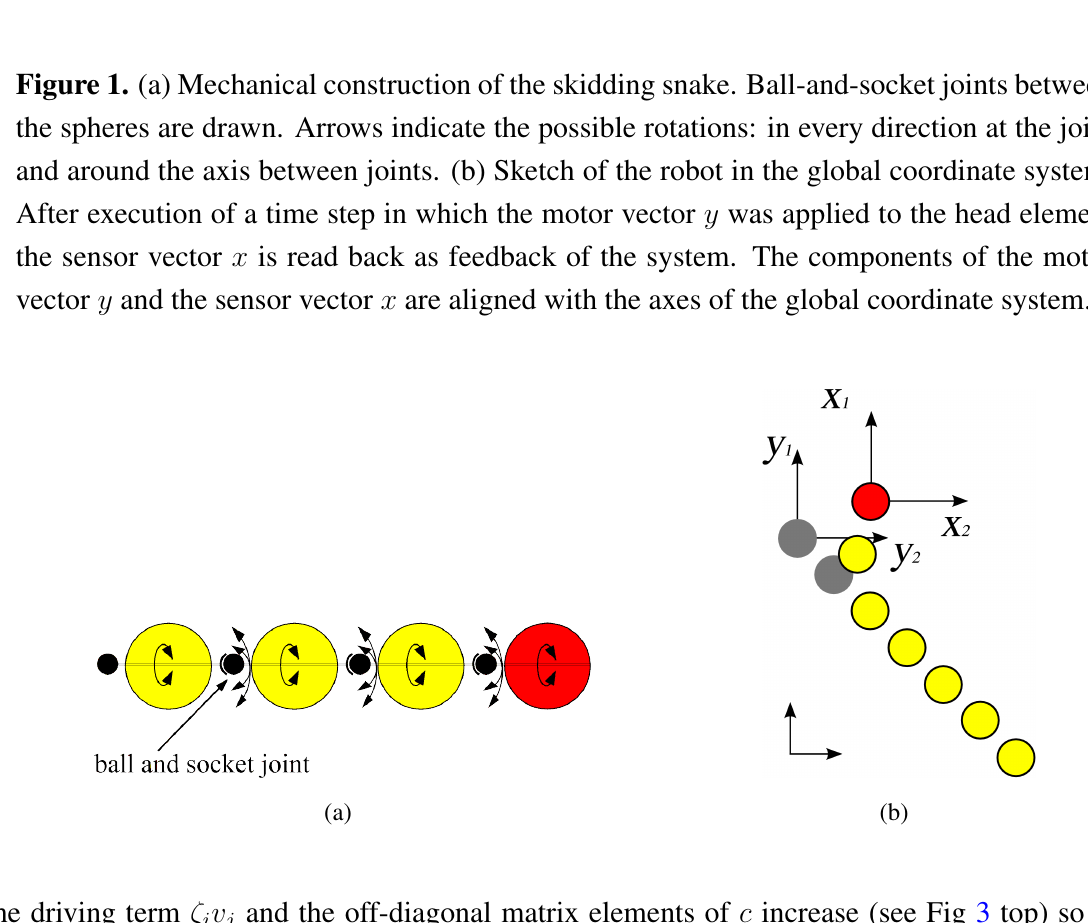
Figure 1. (a) Mechanical construction of the skidding snake. Ball-and-socket joints between the spheres are drawn. Arrows indicate the possible rotations: in every direction at the joint and around the axis between joints. (b) Sketch of the robot in the global coordinate